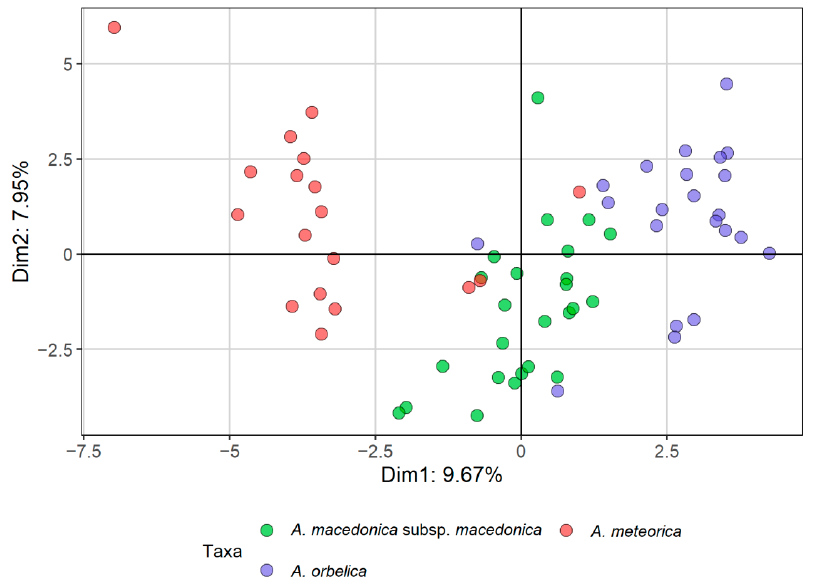
Figure 5. Factor analysis (FAMD) of Anthemis macedonica subsp. macedonica , A. meteorica and A. orbelica , based on 20 quantitative characters, three ratios and 19 qualitative characters.